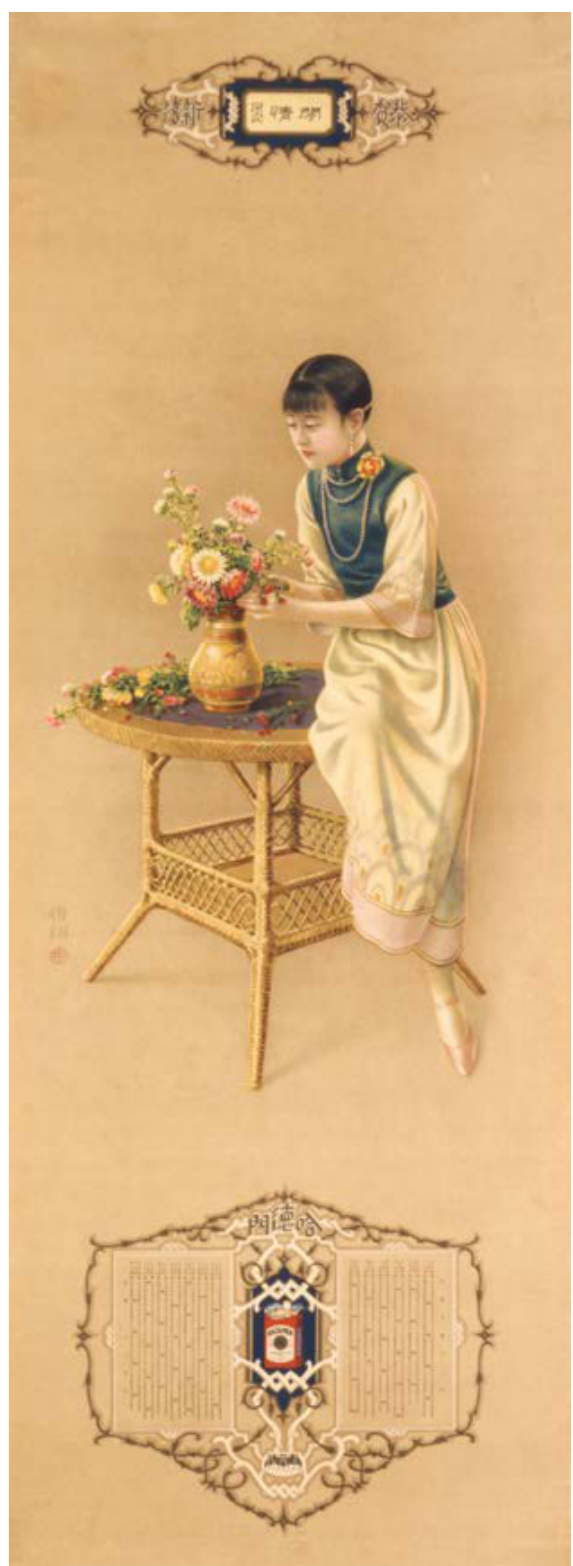
Figure 1 (page 69): Hang Zhiying/Zhiying Studio — Ca- lendar Poster for Fengtian Sino-Russian Tobacco, 1920-30s. Source: Fukuoka Asian Art Museum Figure 2 (pages 70-71): Hang Zhiying/Zhiying Studio — Calendar Poster for Fengtian Sino-Russian Tobacco, 1920-30s. Source: Fukuoka Asian Art Museum. Figure 3 (this and opposite page): Hu Boxiang — Calen- dar Poster for British American Tobacco Co., 1929. Source: Fukuoka Asian Art